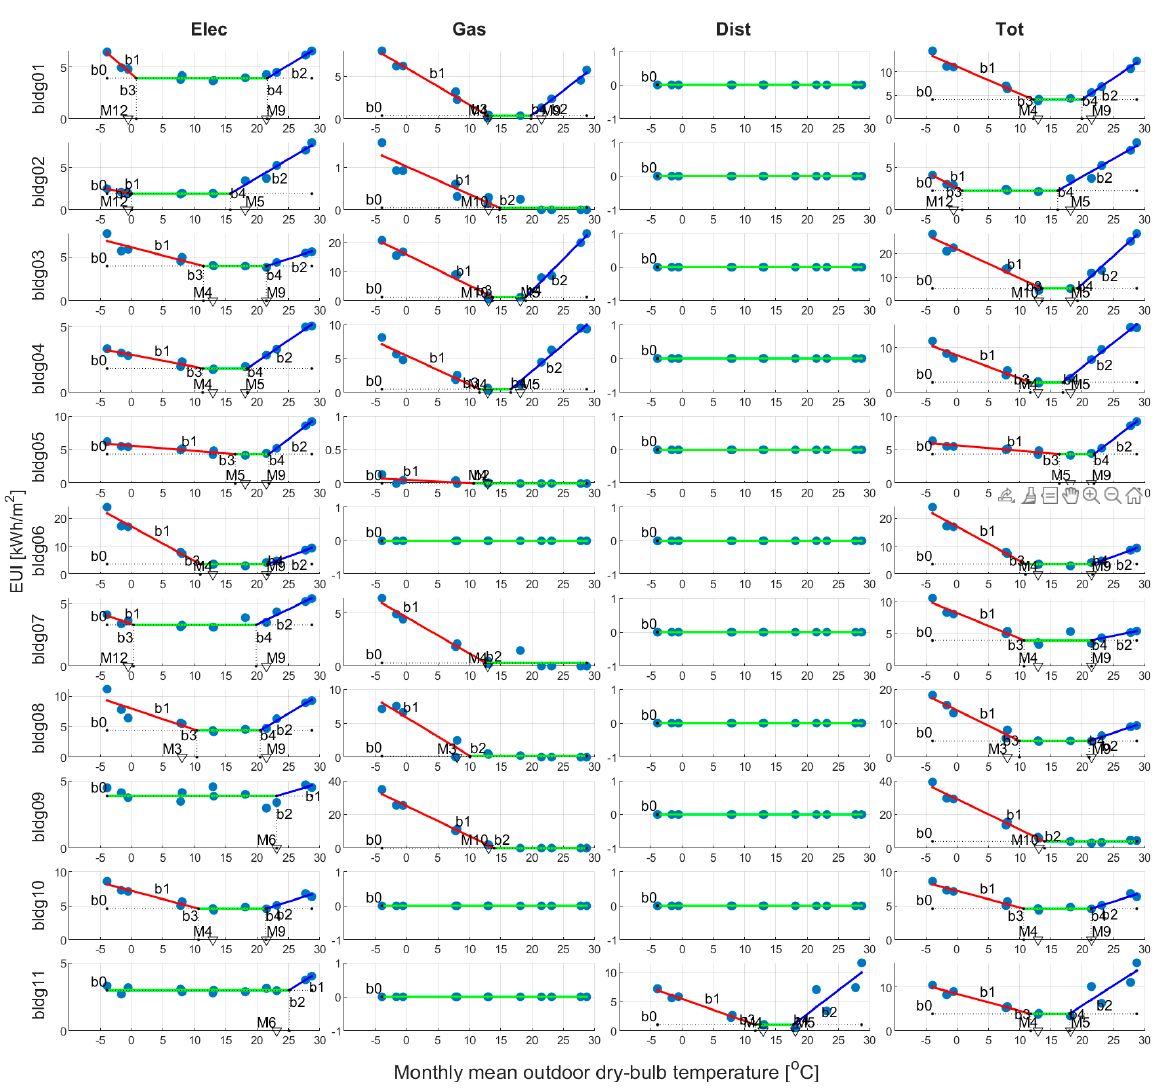
Figure 9. CPR results by energy sources (blue: cooling slope, red: heating slope, green: baseload).